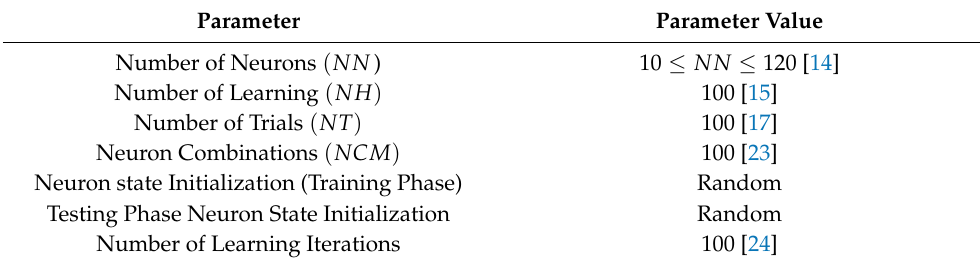
Table 4. List of parameters used for DHNNRAN k